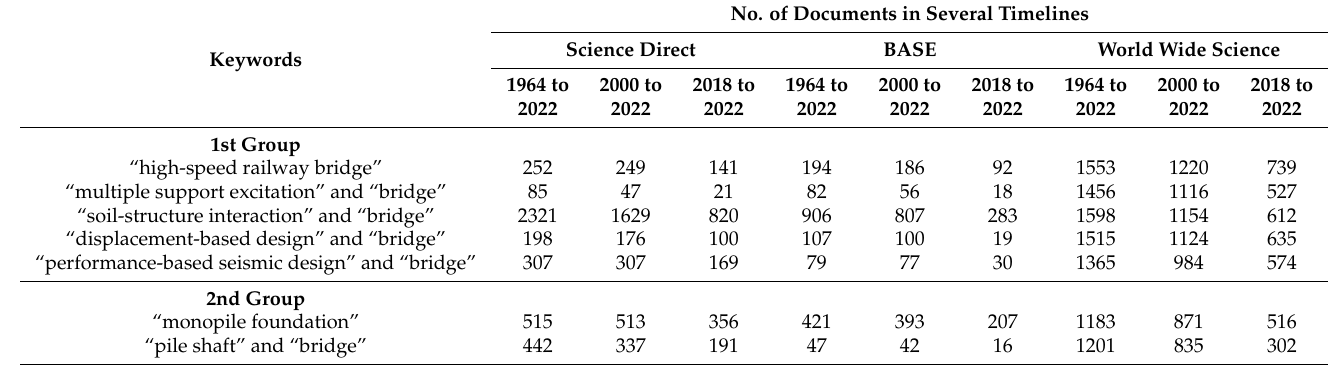
Table 6. Collected electronic data from multiple search systems.